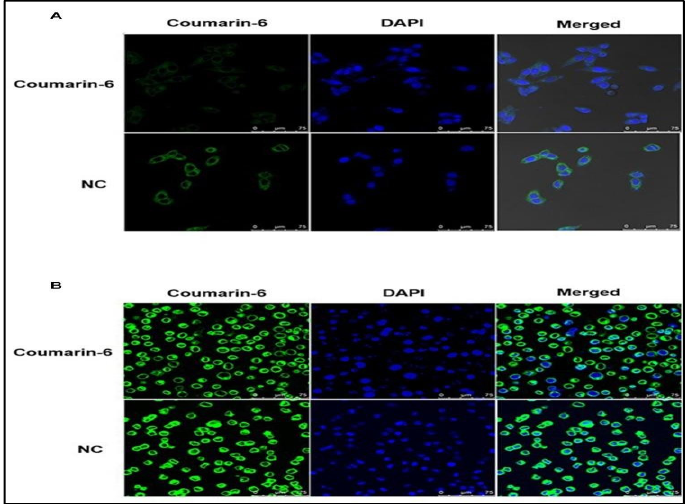
Figure 3. In vitro cellular uptake of nanoparticles. MCF-7 cells ( A ) and MCF-7-MS ( B ) were treated with coumarin-6 and NC after 1 h, followed by staining with DAPI for nuclei. The green fluorescence of coumarin-6 and blue fluorescence of DAPI were analyzed by a confocal laser scanning microscopy (Taken from open access journal under the terms of creative common attributes) [33].